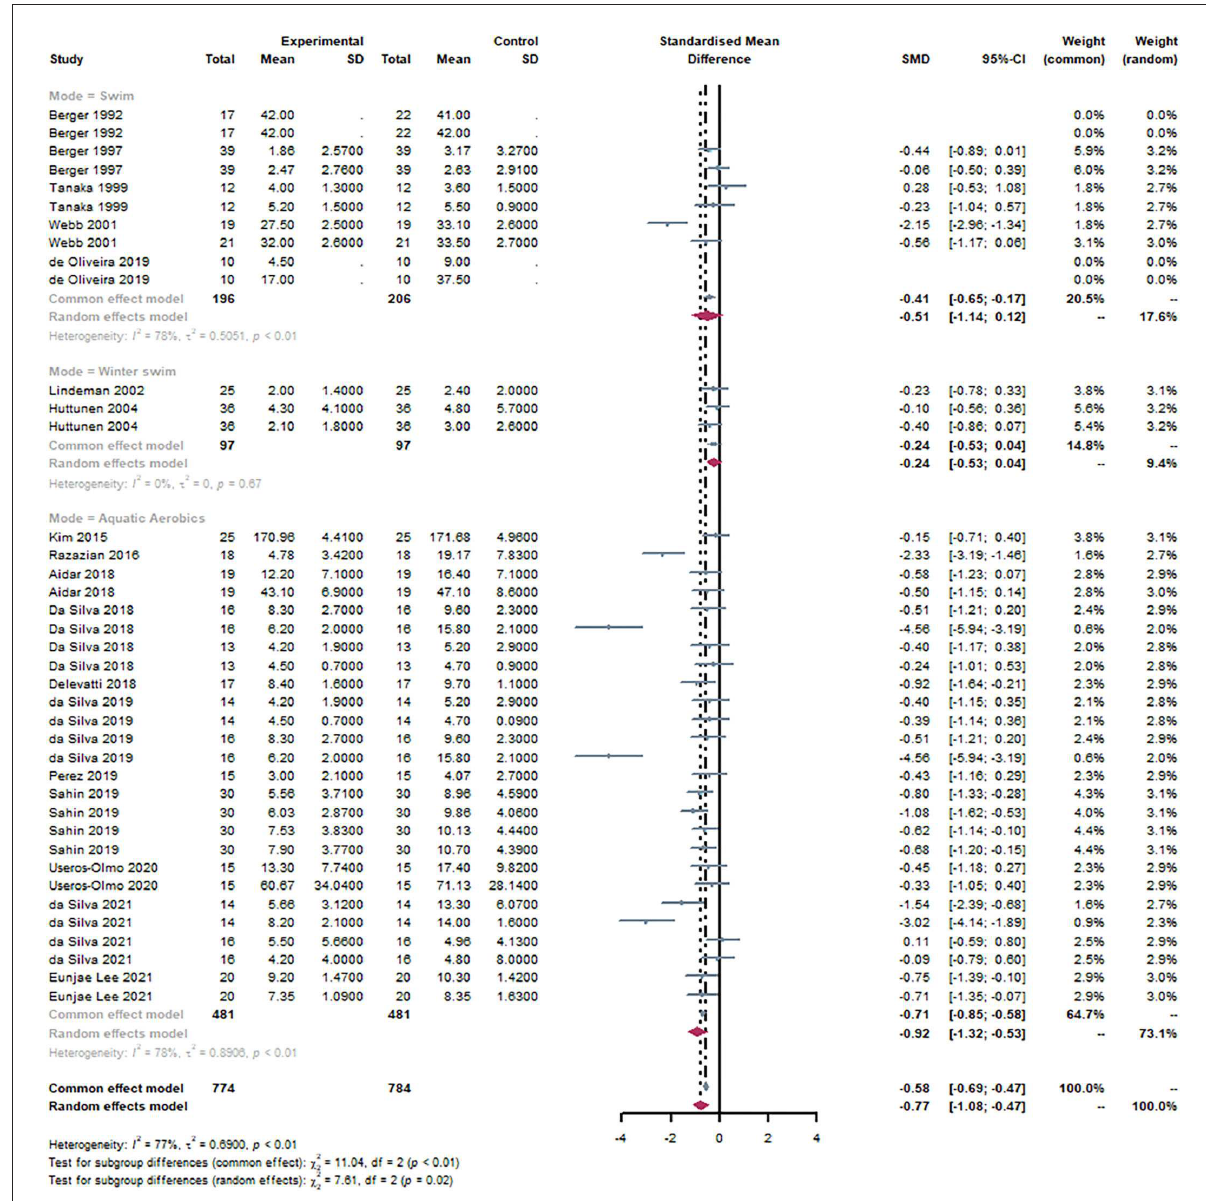
FIGURE7 Forest plot of the mode of exercise. By subgroup analysis of the disease, swimming [SMD = − 0.51, 95% CI ( − 1.14, 0.12), I 2 = 78%, P < 0.01], and aquatic aerobics [SMD = − 0.92, 95% CI ( − 1.32, − 0.53), I 2 = 78%, P < 0.01] were statistically significant.